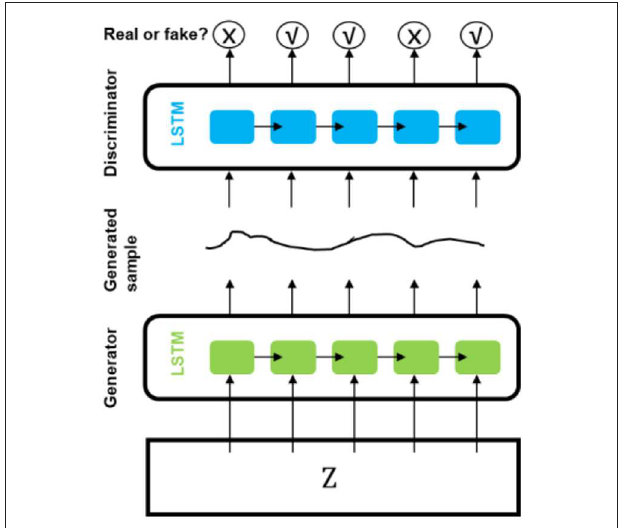
FIGURE 4 | The architecture of LSTM-based GAN in medical